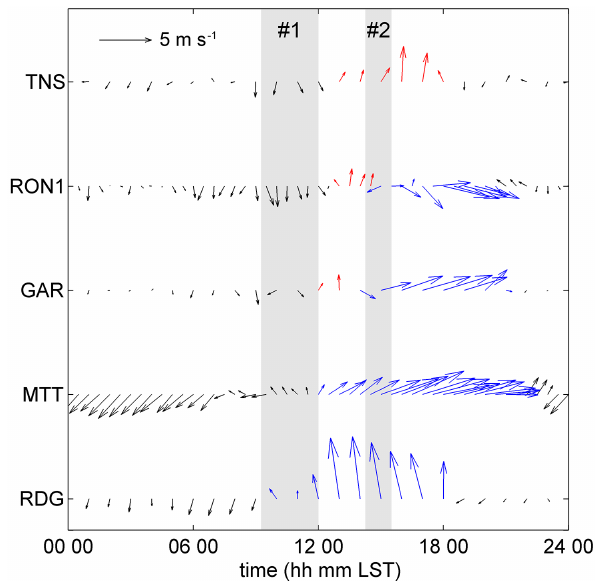
Figure 3. Wind observations for 23 August 2001 at RDG (5m a.g.l.) in the Sarca Valley, MTT (3m a.g.l.) at the end of the Lakes Valley, GAR (3m a.g.l.), RON1 (10m a.g.l.) and TNS (10m a.g.l.) in the Adige Valley (see Fig. 2 and Table 2 for name and location of the AWSs). For the sake of clarity, MTT and RON1 data are aggregated as 30min (backward) averages. Data from RDG, GAR and TNS are 1h backward averages. Notice that the blue arrows correspond to the Ora del Garda, while the red arrows correspond to the Adige Valley up-valley wind. The duration of flights 1 and 2 is indicated by the grey